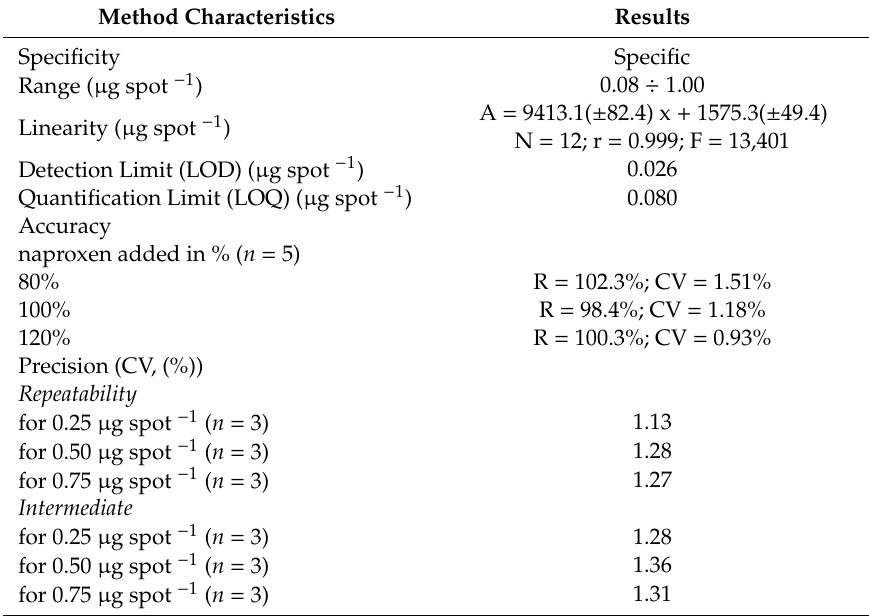
Table 4. Validation of TLC-densitometric method for naproxen analyzed using mobile phase B a . Method